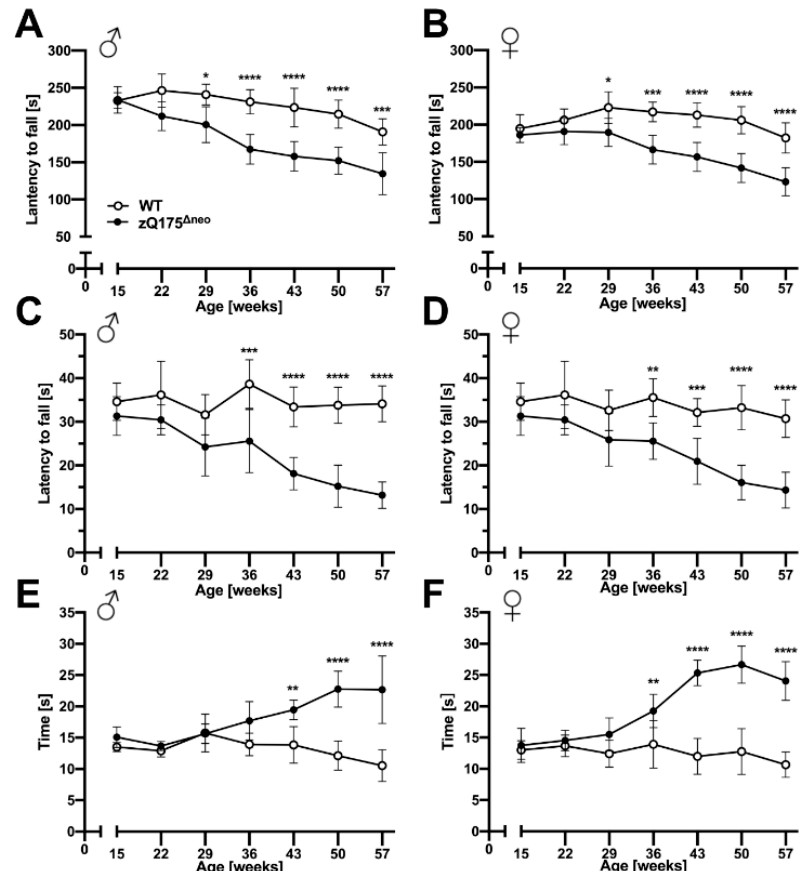
Figure 5. zQ175 Δ neo mice exhibited robust, progressive motor abnormalities compared to WT mice. The motor performance of male ( A , C , E ) and female ( B , D , F ) WT ( ○ ) and zQ175 Δ neo mice ( ● ) was assessed at 7-week intervals by performing accelerating rotarod ( A , B ), wire hang ( C , D ), and pole ( E , F ) performance tests. Data are presented as mean ± SD; N = 4–6. Significance was calculated using two-way ANOVA with Bonferroni’s multiple comparisons test and is given as *: p ≤ 0.05, **: p ≤ 0.01, ***: p ≤ 0.001, and ****: p ≤ 0.0001.